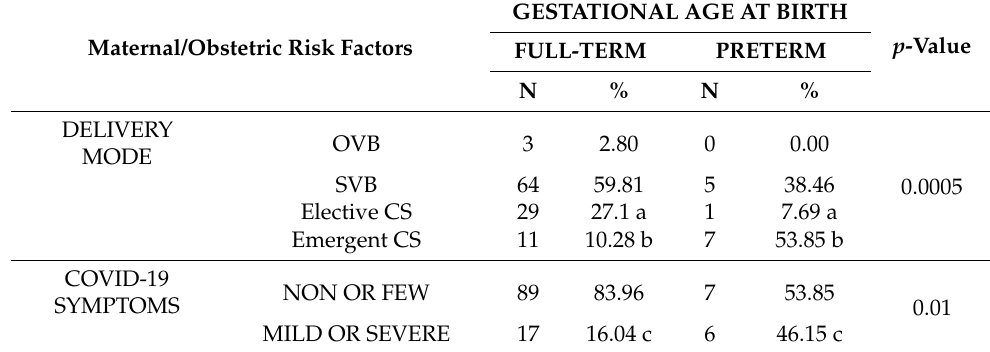
GESTATIONAL AGE AT BIRTH